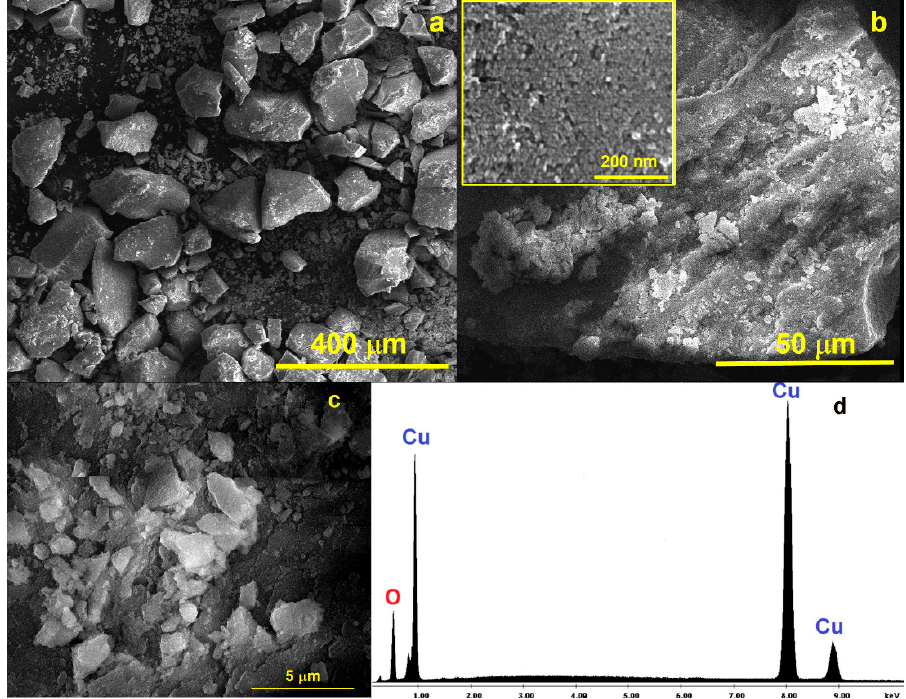
Figure 3. SEM micrographs of the CuONP material at different magnifications: ( a ) 400 µ m; ( b ) 50 µ m (inset: details of one aggregate at 200 nm showing the spherical nanosized CuONP particles); ( c ) 5 µ m; and ( d ) EDAX spectrum for the CuONP